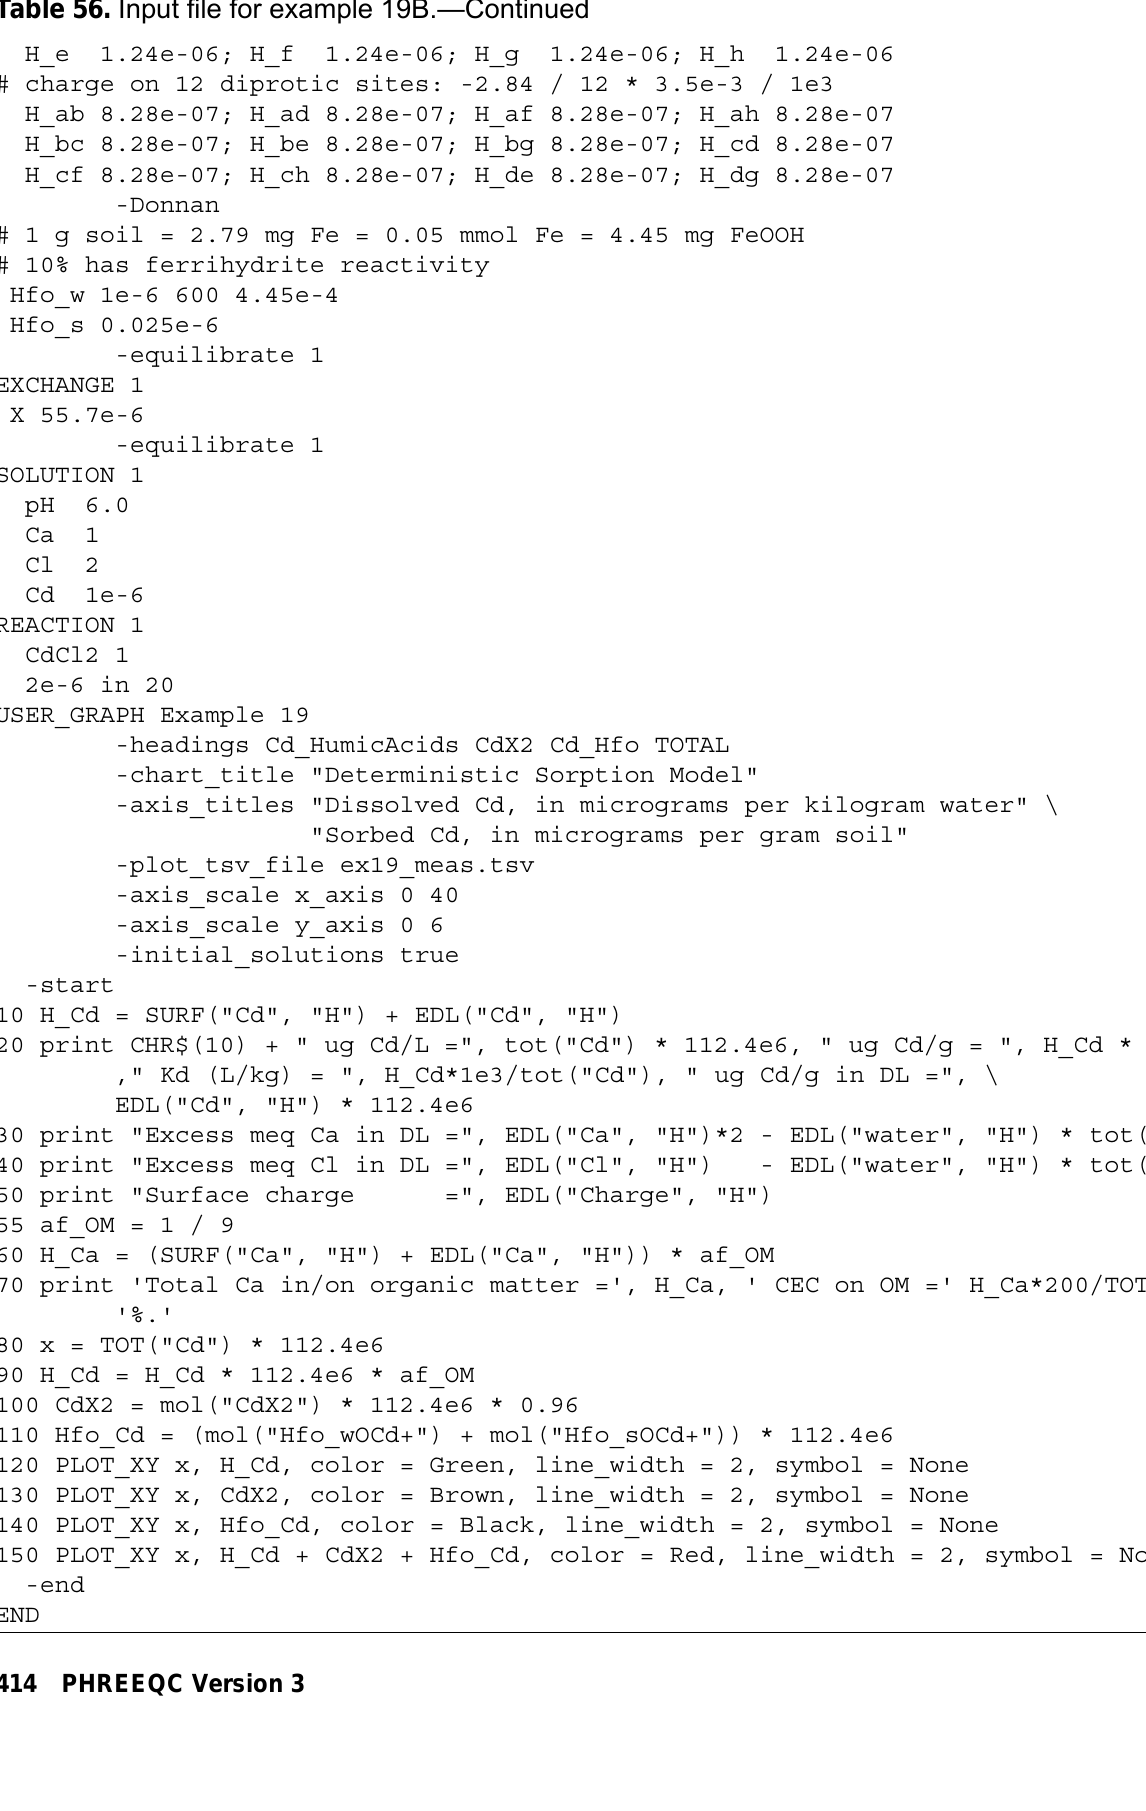
Table 56. Input file for example